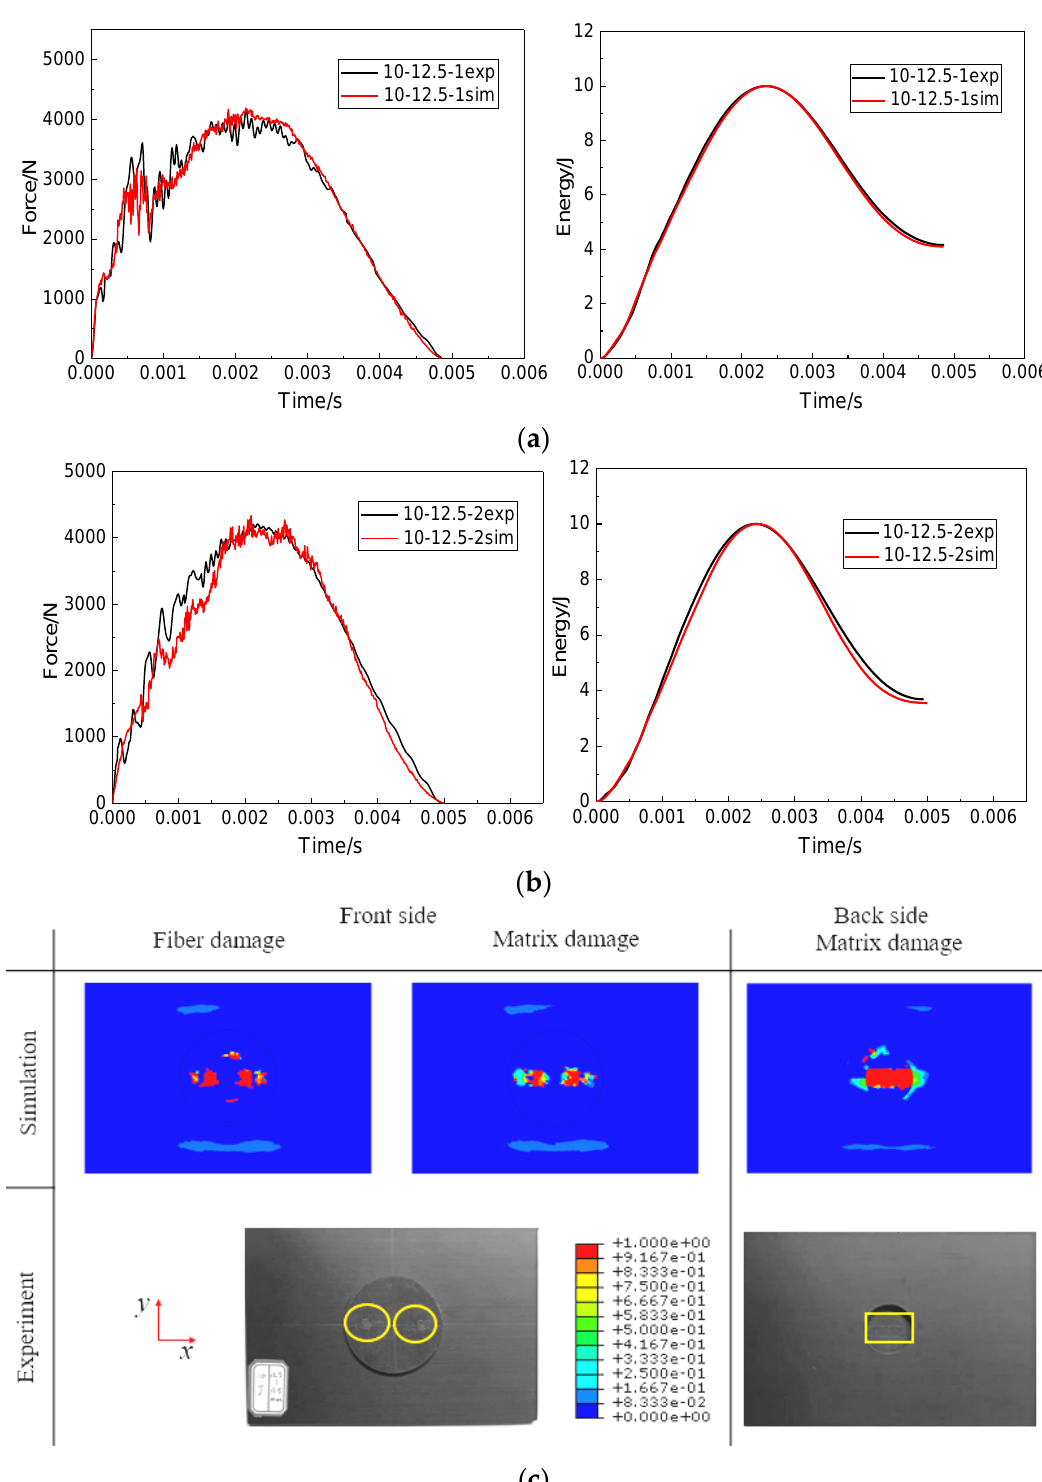
Figure 12. Comparisons of force–time curves and impact energy curves between the simulation results and the corresponding experiment results at an impact distance of 12.5 mm: ( a ) the first impact, ( b ) the second impact and ( c ) comparisons of the damage profiles after the second